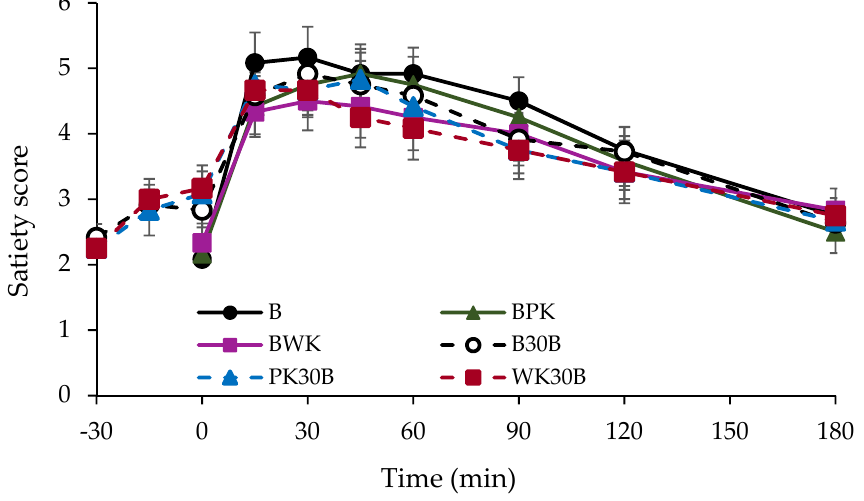
Figure 2. Changes in satiety score. Data are presented as mean ± SEM.